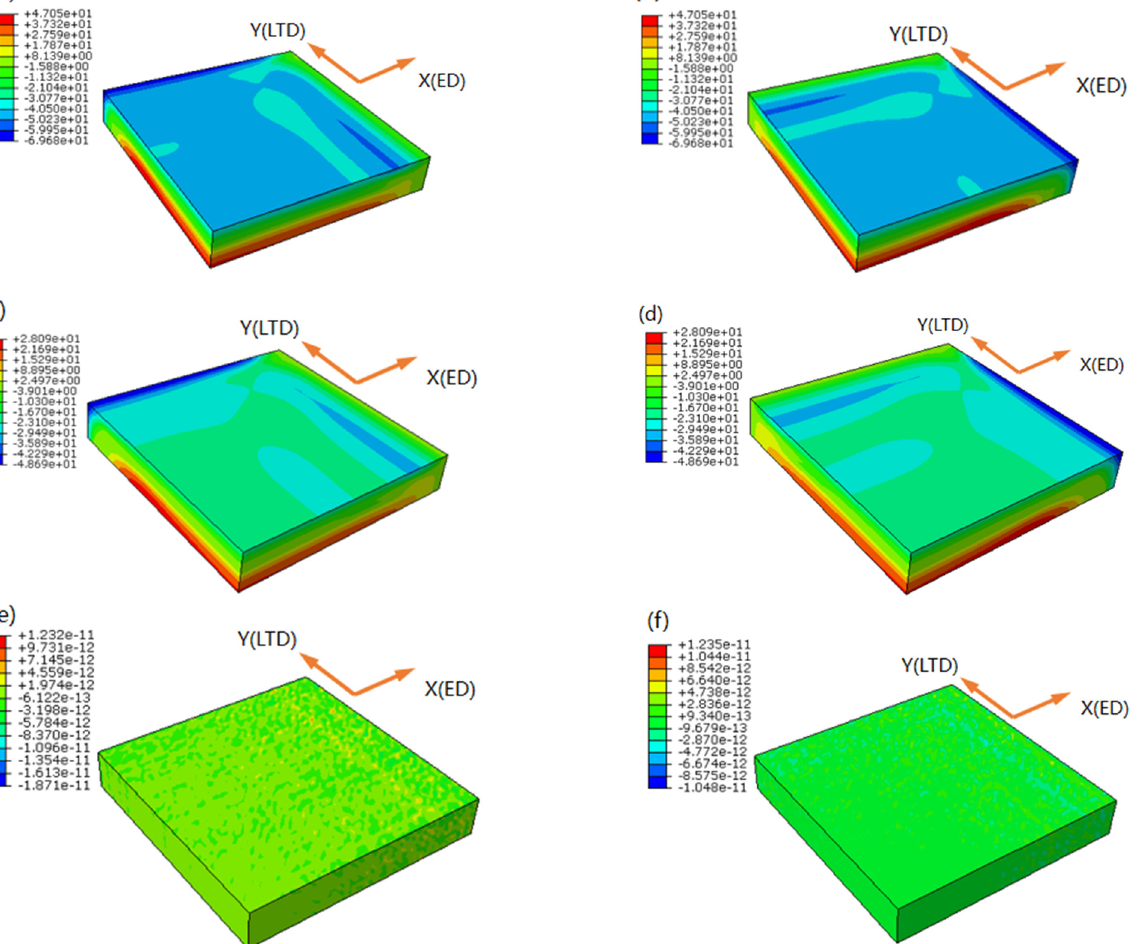
Figure 9. Simulation results of the distribution of ( a ) σ x in WQ (20 °C), ( b ) σ y in WQ (20 °C), ( c ) σ x in WQ (100 °C), ( d ) σ y in WQ (100 °C), ( e ) σ x in AC and ( f ) σ y in AC.